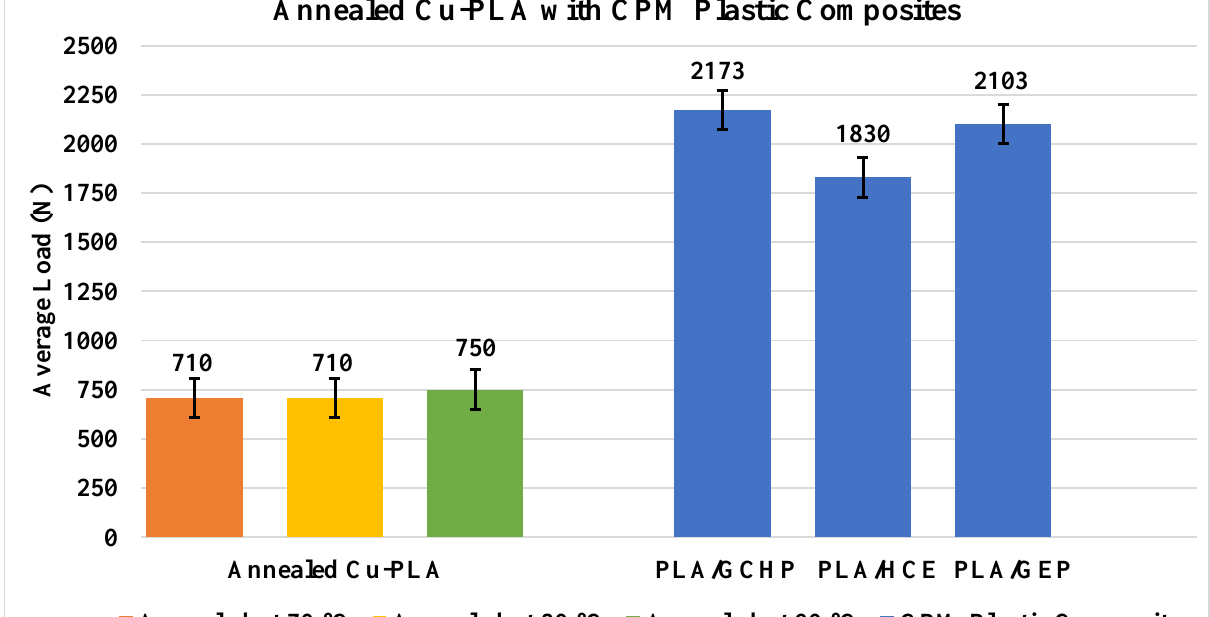
Figure 8. Results of annealed Cu-PLA with CPM plastic composites.